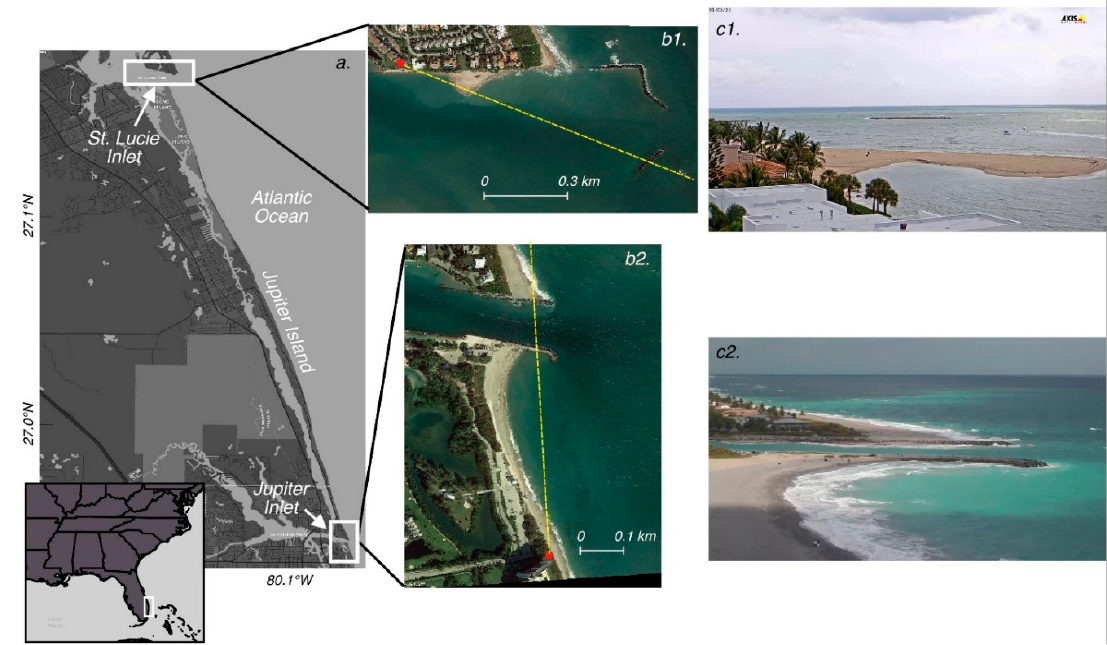
Figure 1. Surf-camera study sites. ( a ) Location of the surfcams on the north and south ends of Jupiter Island, Florida. ( b ) Satellite images of the surf-camera locations (red dots) and optical axes (yellow lines) for the St. Lucie ( b1 ) and Jupiter ( b2 ) cameras. ( c ) Example snapshots from the St. Lucie ( c1 ) and Jupiter ( c2 ) cameras.